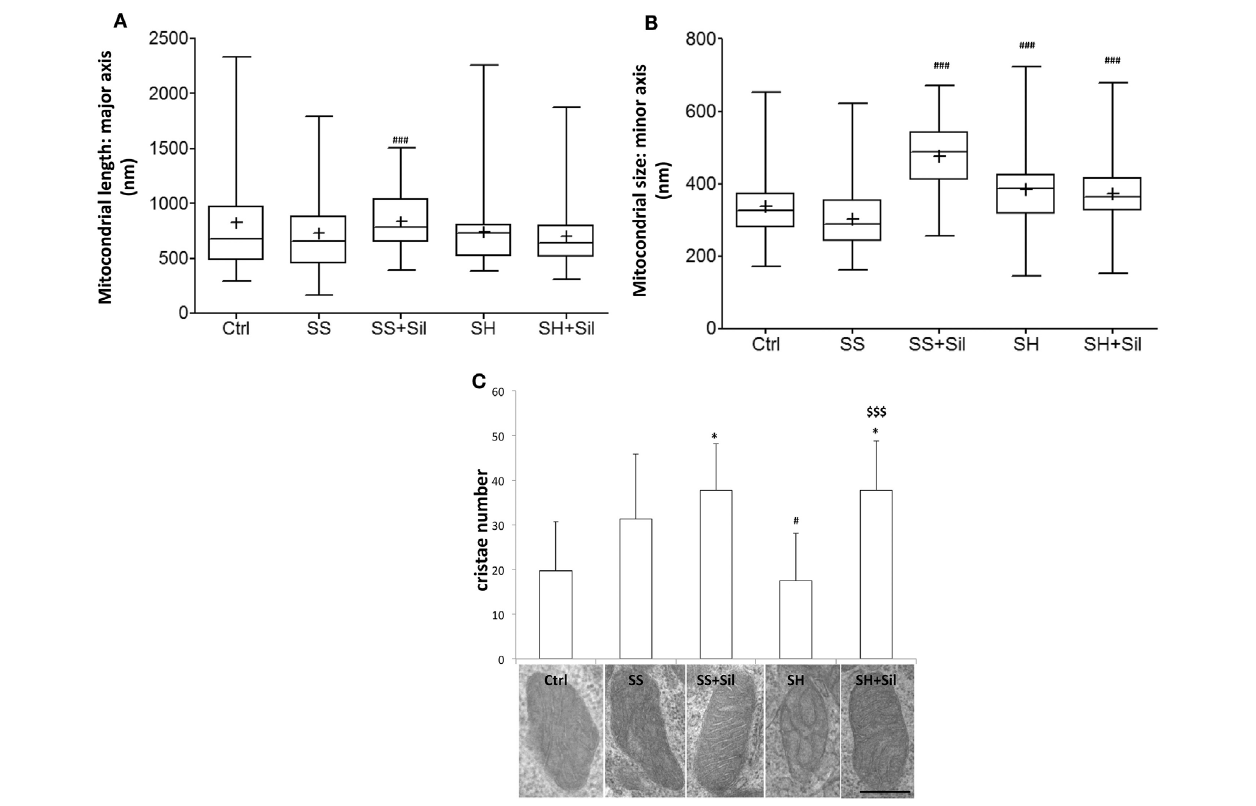
FigUre 6 | Effect of silybin on mitochondrial shape. Under the conditions of Figure 1 , cells were analyzed by electron microscopy and the following parameters were assessed: (a) mitochondrial length (major axis) and mitochondrial size (minor axis) (b) were measured. The results were plotted as box-and-whisker plot, showing the interquartile range, the median as horizontal bar and the whiskers are the minimum and maximum values. (c) Cristae number was also evaluated. Values are mean ± SD from all mitochondria scored in 20 images for each experimental condition. Representative electron micrographs of randomly selected mitochondria from each experimental condition are also shown. (magnification 25k; scale bar: 0.5 µm). Significant differences are denoted by symbols: Ctrl vs all treatments, * p ≤ 0.05; simple steatosis (SS) vs all treatments ### p ≤ 0.001 and # p ≤ 0.05; steatohepatitis (SH) vs all treatments $$$ p ≤